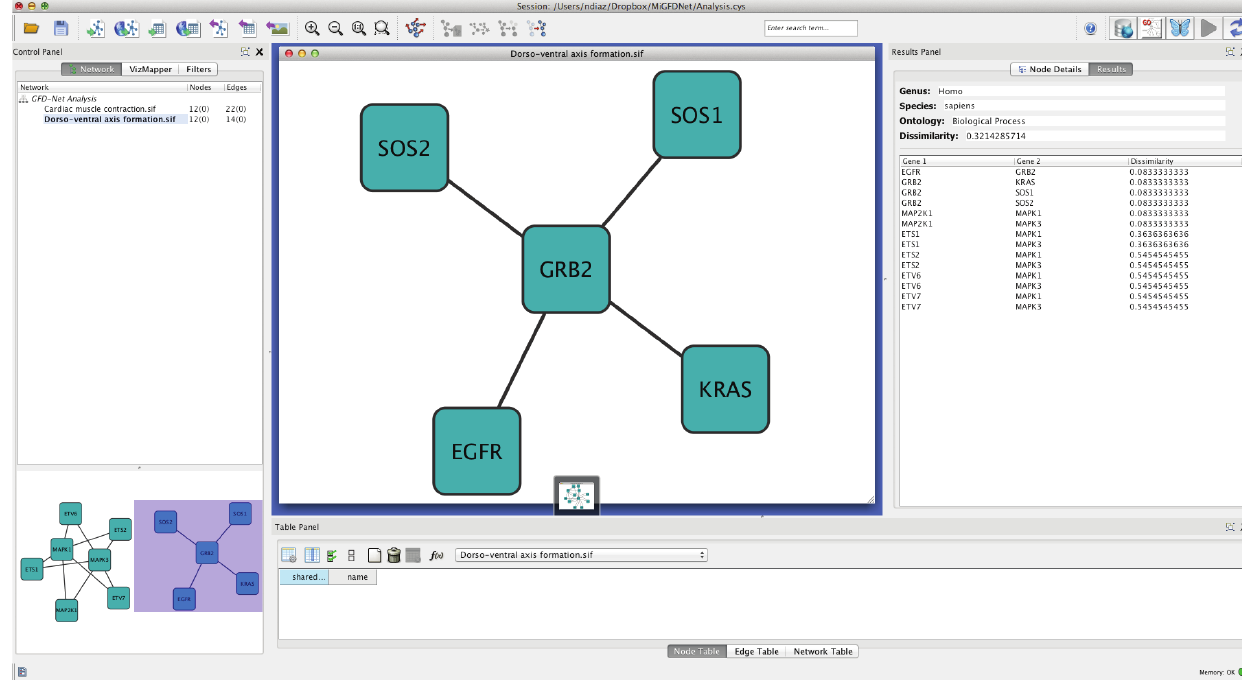
Figure 2. Screenshot showing what the default result panel looks like. It shows how the more specific genes are highly related while the more generic ones are